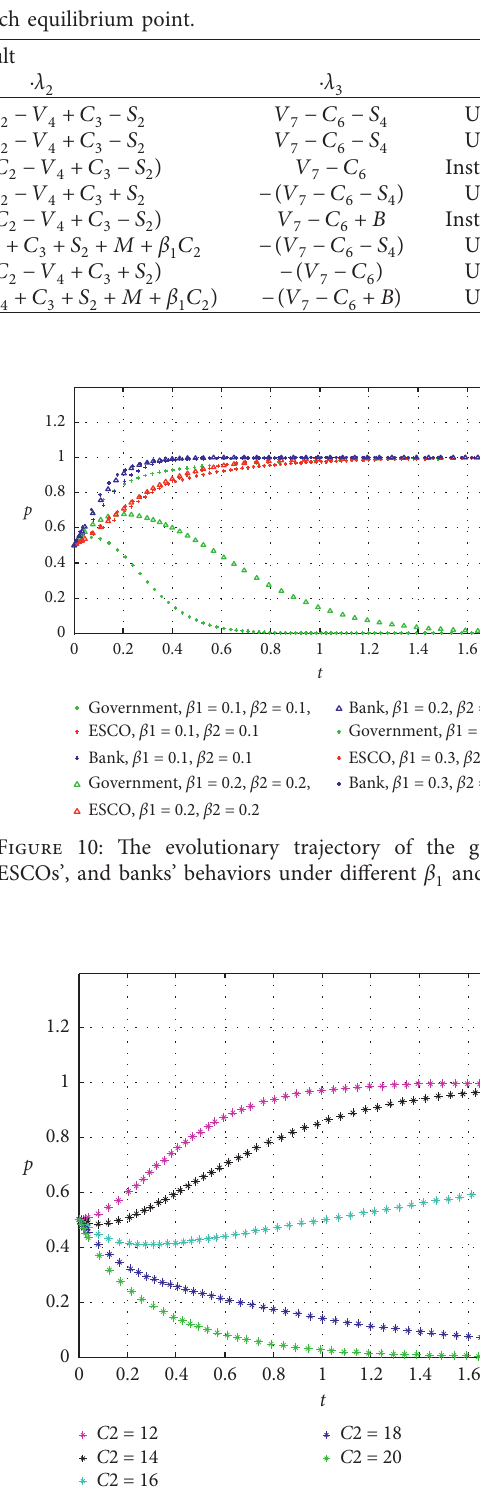
Figure 11: ESCOs’ behavior evolution trajectory under different